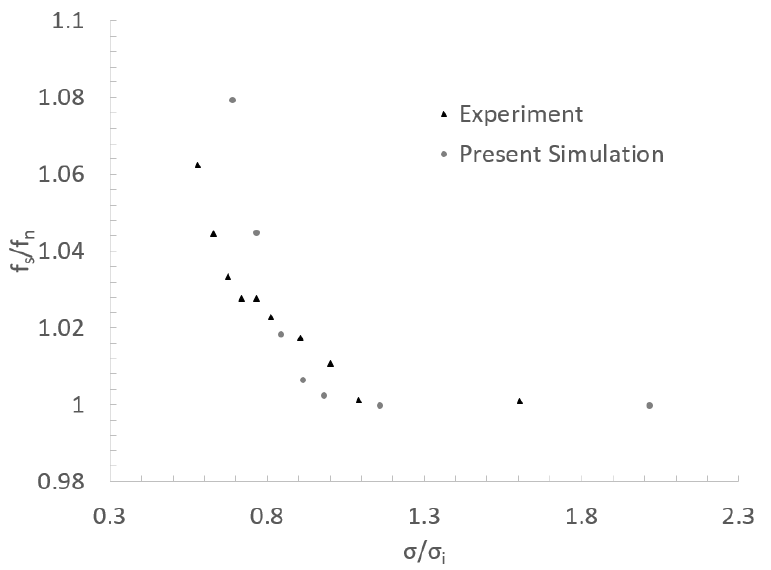
Figure 6. Comparison of the vortex shedding frequencies estimates between the numerical simulations and the experimental measurements (Ausoni et al. [6]) as a function of the relative sigma value.